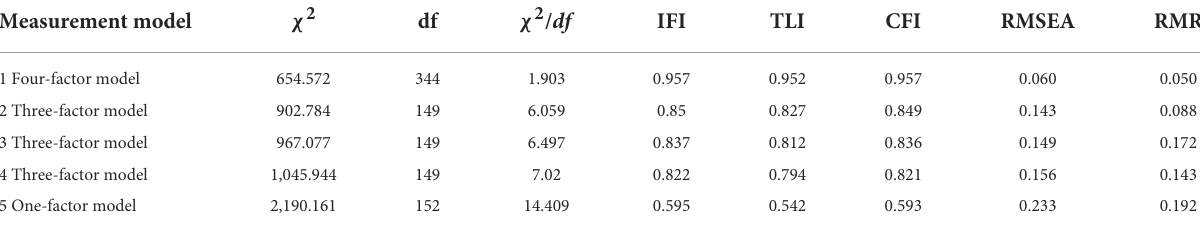
TABLE 3 CFA model fit indices.